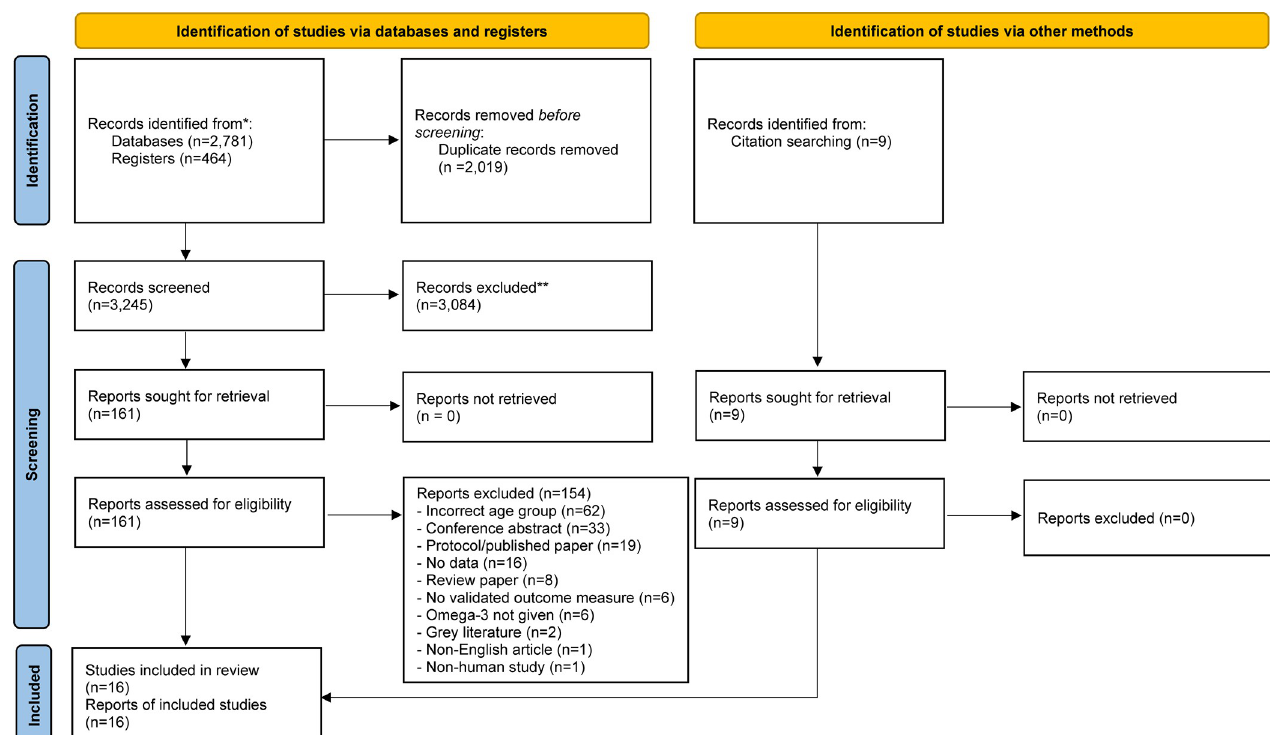
Fig 1. PRISMA flow diagram: Scientific literature screening process.